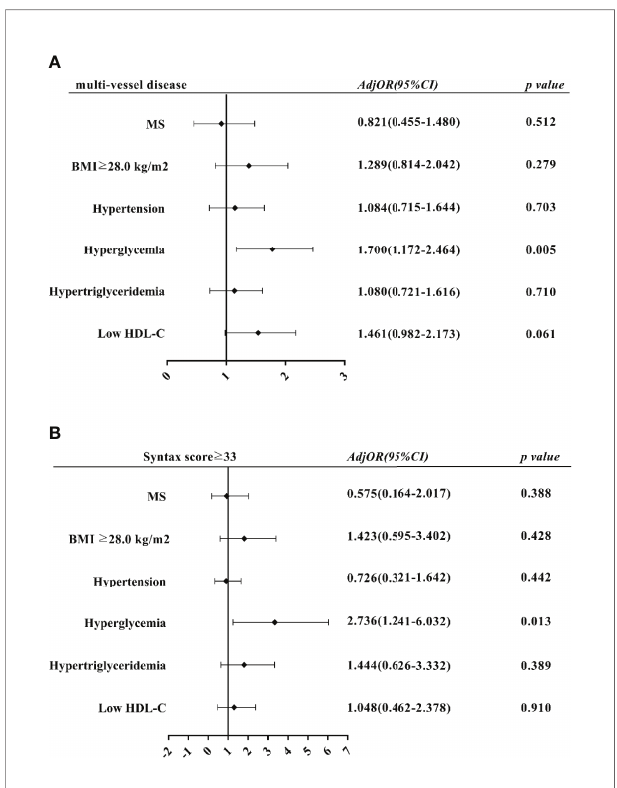
( Table 2 ). In addition, AMI patients with prior PCI, prior CABG, LVEF <40%, high fasting blood glucose, high CK, high CK-MB, high hs-CRP, high hs-TNT, multi-vessel disease, or Syntax score ≥ 33 were positively associated with the occurrence of MACE (all P <0.05, Supplementary Table ). A signi fi cant difference was found in the KM curve between the two groups ( P < 0.001) ( Figure 2A ). Cox regression analysis showed that MS was an independent risk factor for MACE